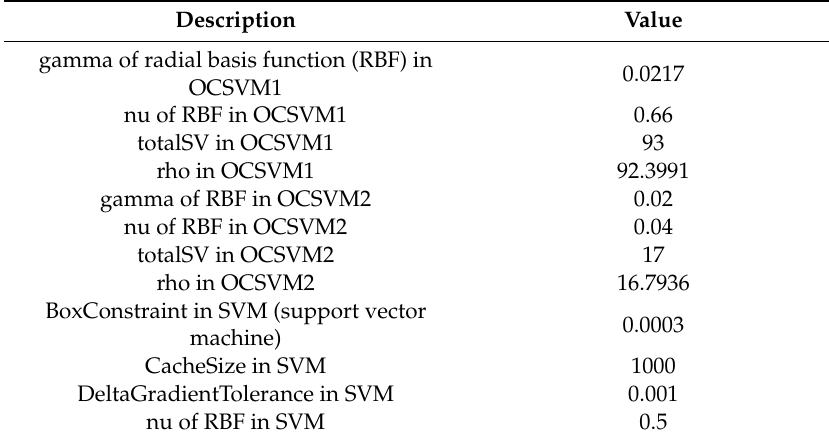
Table 3. Parameters of the proposed method.